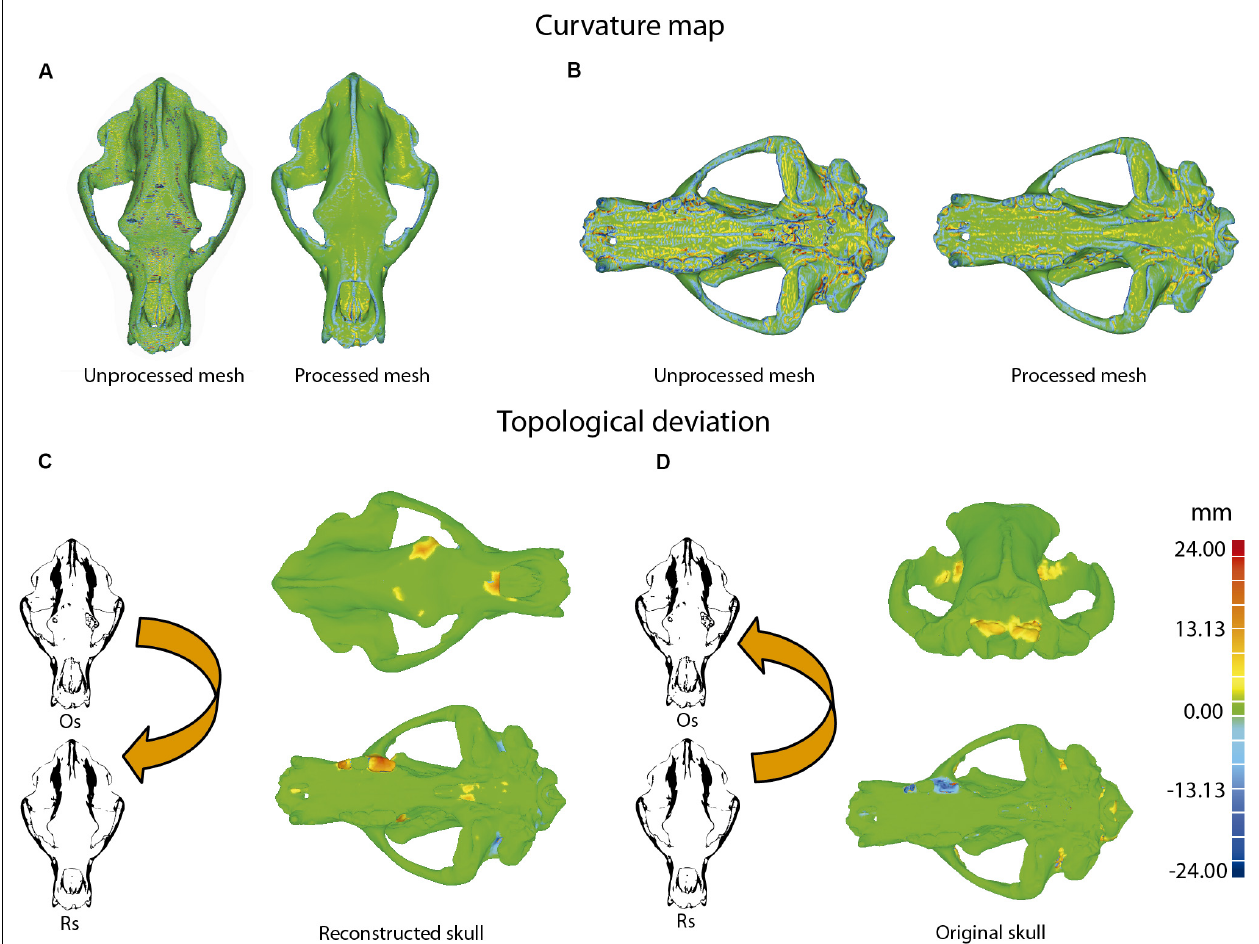
FIGURE 12 | Example of topological deviations using the dataset of Ursus spelaeus spelaeus (E-ZYX-1000). (A,B) First postprocessed mesh, consisting of curvature maps, in dorsal view (A) of the unprocessed mesh (left side), and the reconstructed skull (right side), and in ventral view (B) of the unprocessed mesh (left side) and the processed mesh reconstructed skull (right side). (C,D) Topological variation between the original (Os) and reconstructed (Rs) meshes using either the original skull as a reference (C) or the reconstructed one (D) . Note that parts added in the reconstructed skull appear in warm colors when the original skull is used as a reference but appear blue when the reconstructed skull is used as a reference. Os, original skull; Rs, reconstructed